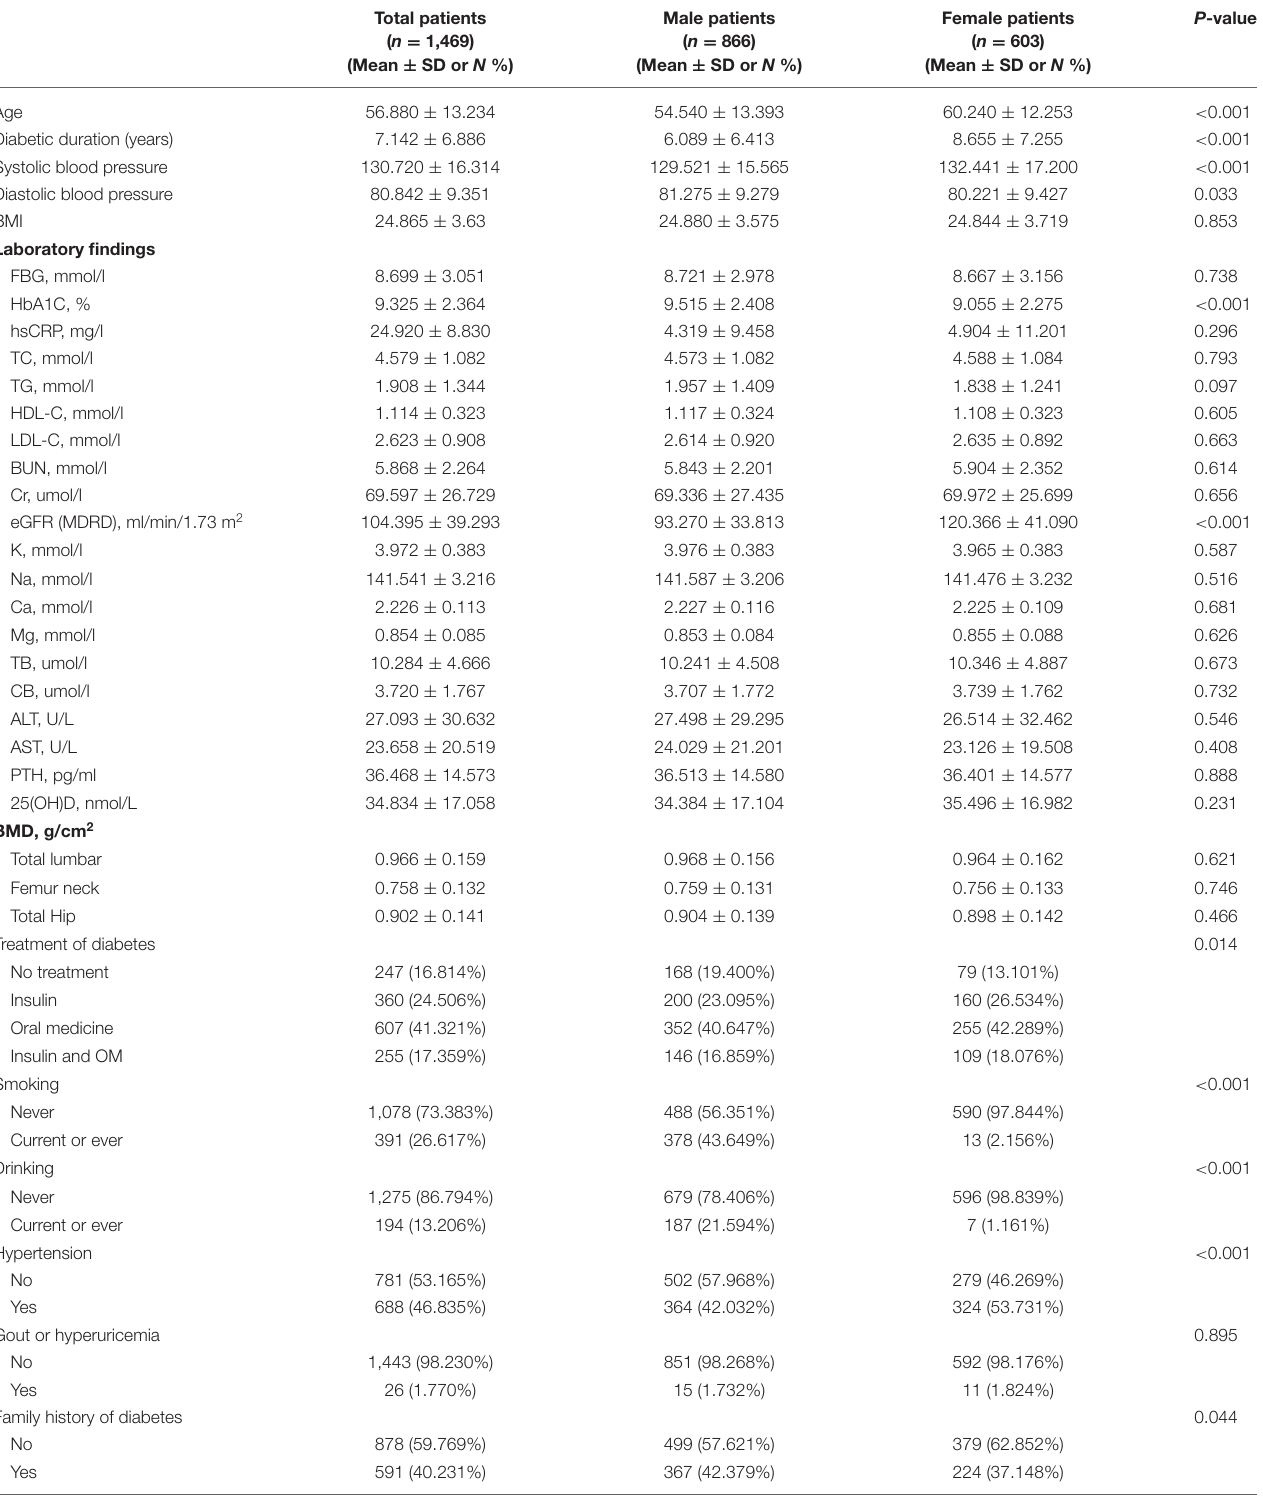
TABLE 1 | Patient characteristics, stratified by